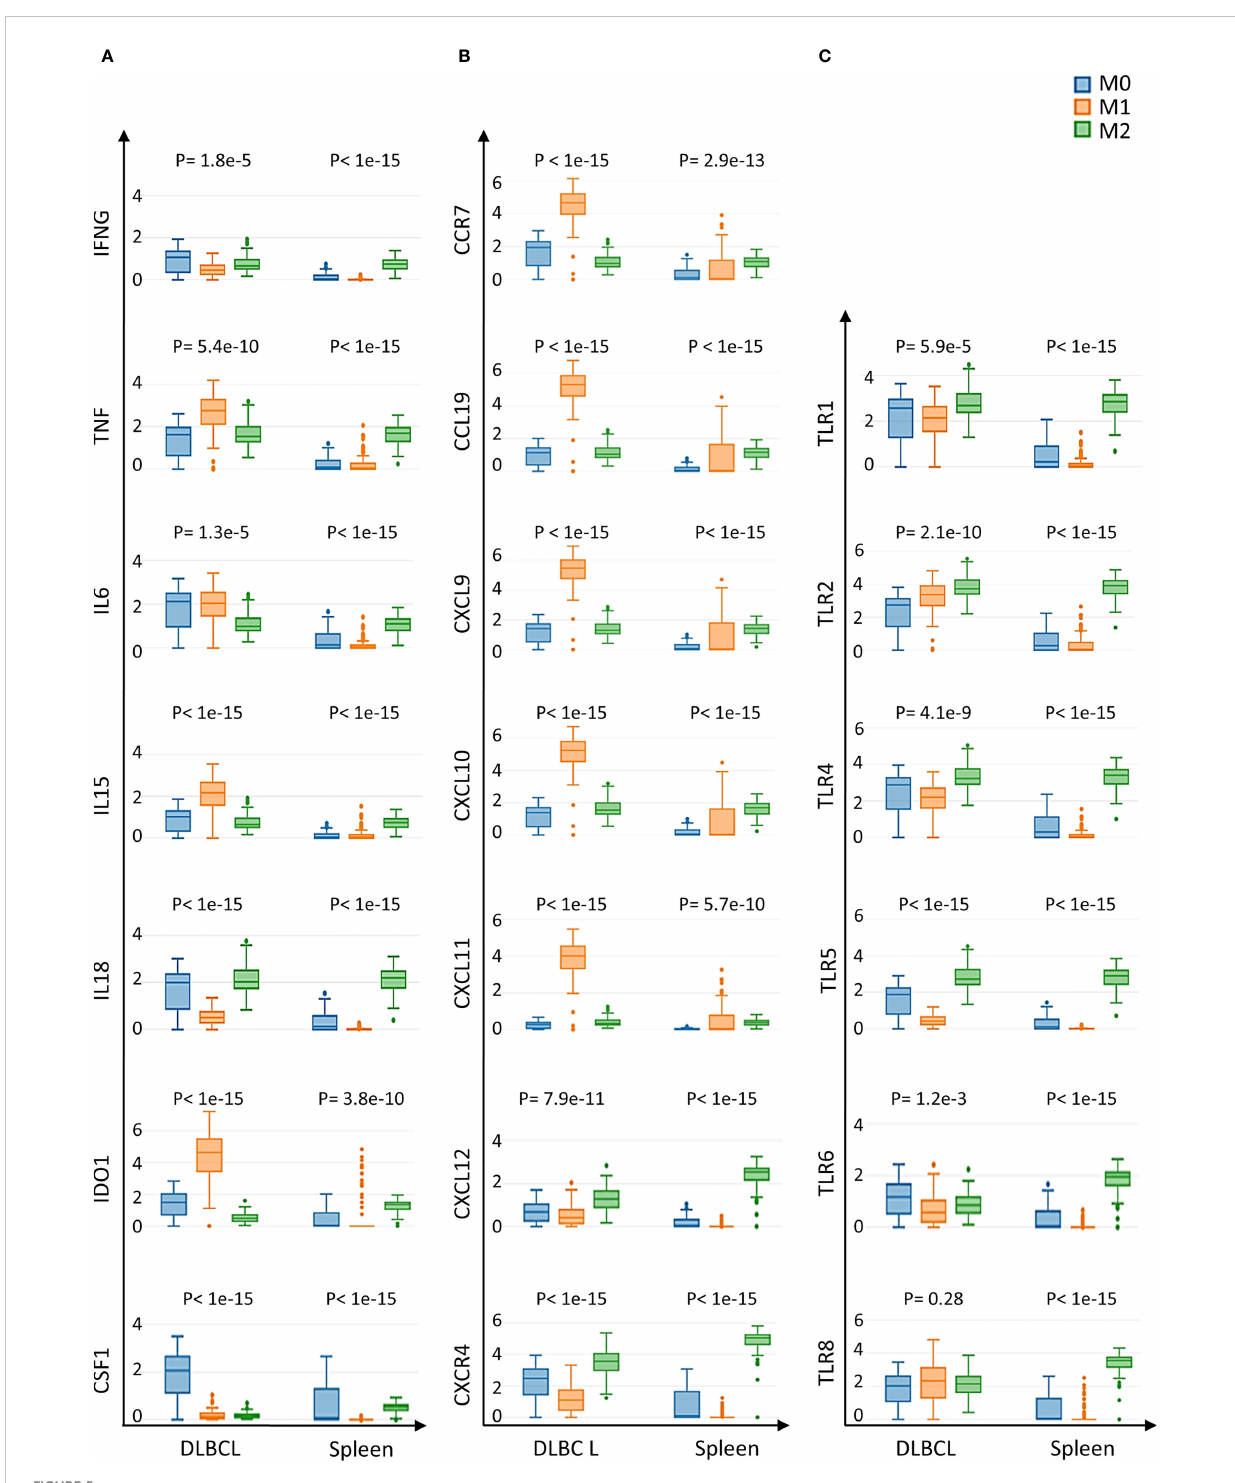
FIGURE 5 Expression of cytokines and TLRs in M0, M1 and M2 macrophages of DLBCL and spleen tissue samples (A) Gene expression of the indicated interleukins in M0, M1 and M2 macrophages in 47 DLBCL samples (TCGA database) and in 337 spleen tissue samples (normal secondary lymphoid organ; GTEx database). (B) Gene expression of the indicated chemokines and their receptors in M0, M1 and M2 macrophages in the same samples as in (A) . (C) Expression of TLR- encoding genes in M0, M1 and M2 macrophages in the same samples as in (A) . Y-axis: log (TPM+1) of the expression levels of the indicated gene. Additional data are in Tables 2, 3. P ≤ 0.05 (one-way ANOVA) was considered signi fi cant. TPM, transcript count per million reads. It is important to note that the results of the deconvolution analyses in Figures 3, 4 display comparisons according to the tissue type (DLBCL and spleen) and not the cell type (M0, M1 and